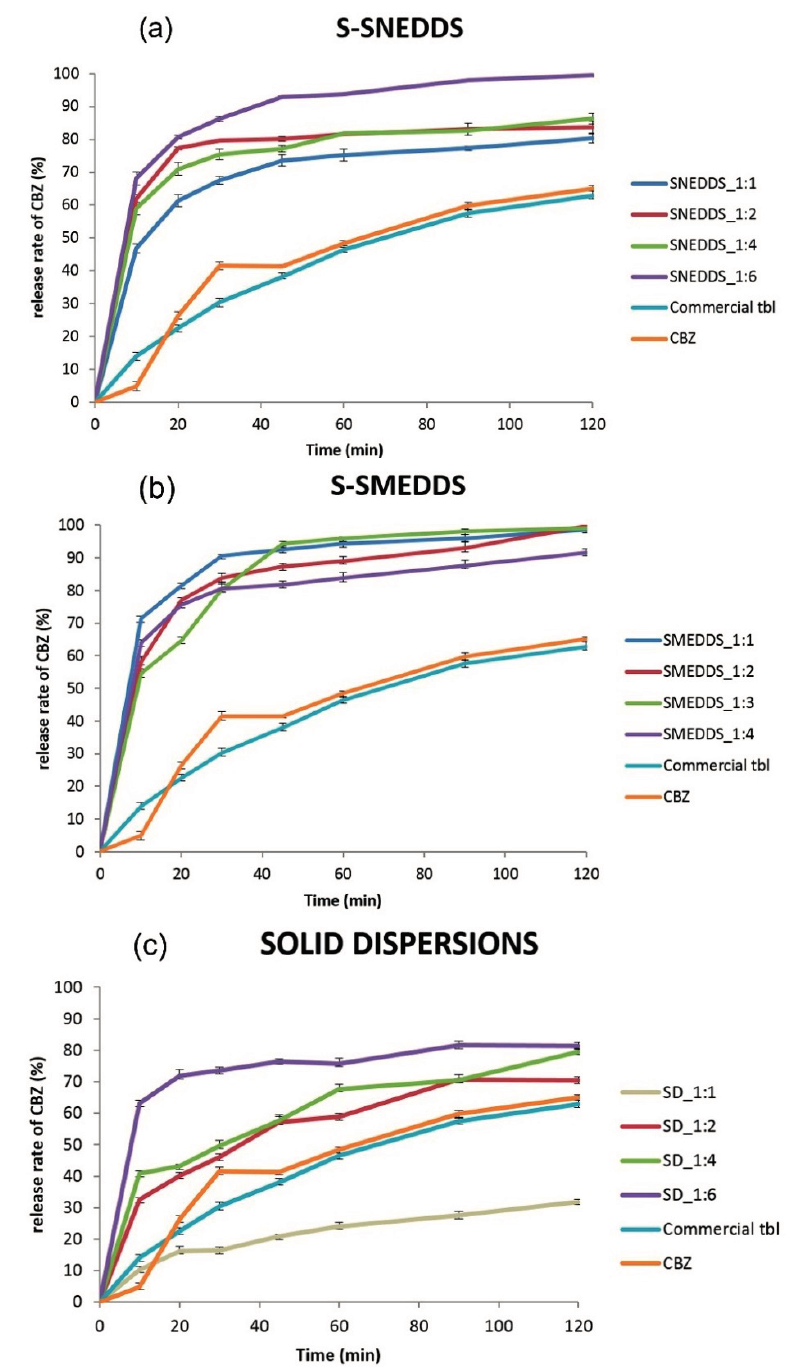
Figure 5. In vitro dissolution profiles ofcarbamazepine and commercial tablets in comparison with formulations prepared in our laboratory: S-SNEDDS ( a ); S-SMEDDS ( b ); and solid dispersions ( c